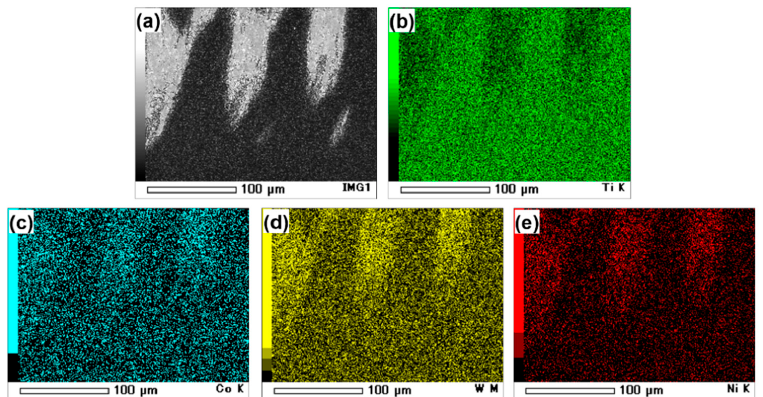
Figure 2. ( a ) SEM image and electron probe microanalysis (EPMA) (composition) maps for ( b ) titanium, ( c ) cobalt, ( d ) tungsten, and ( e ) nickel taken from the advancing side of the stir zone.